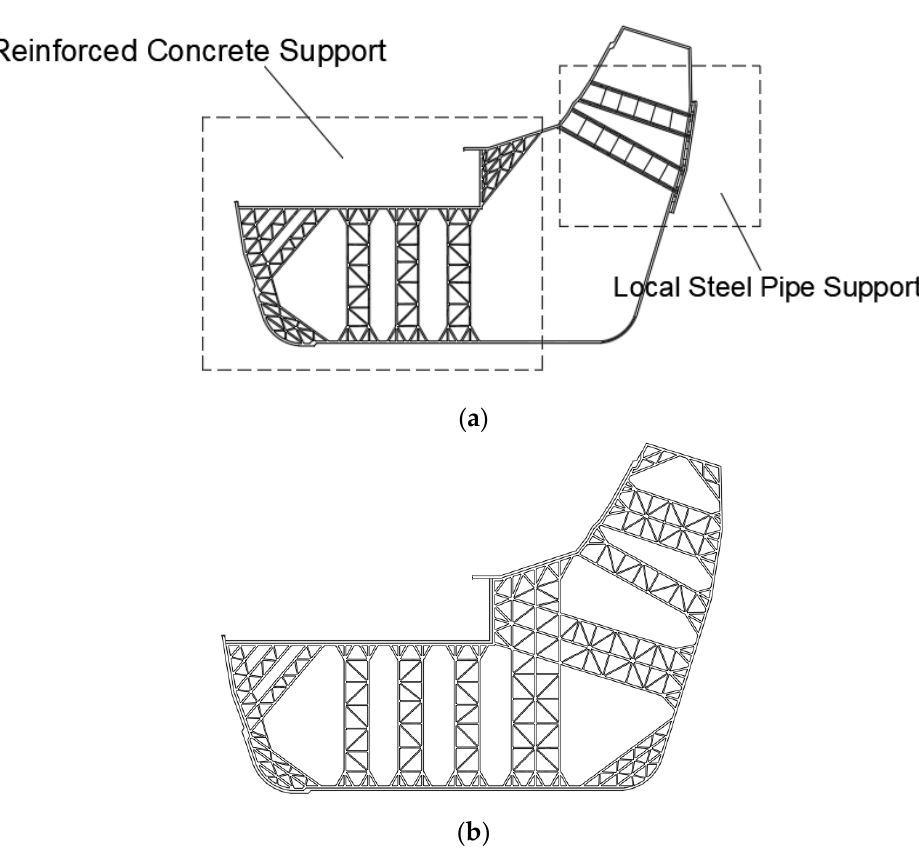
Figure 3. Support layout in section A of the foundation pit. ( a ) Layout of inner support on the first layer; ( b ) Layout of 2nd, 3rd and 4th layer inner support.